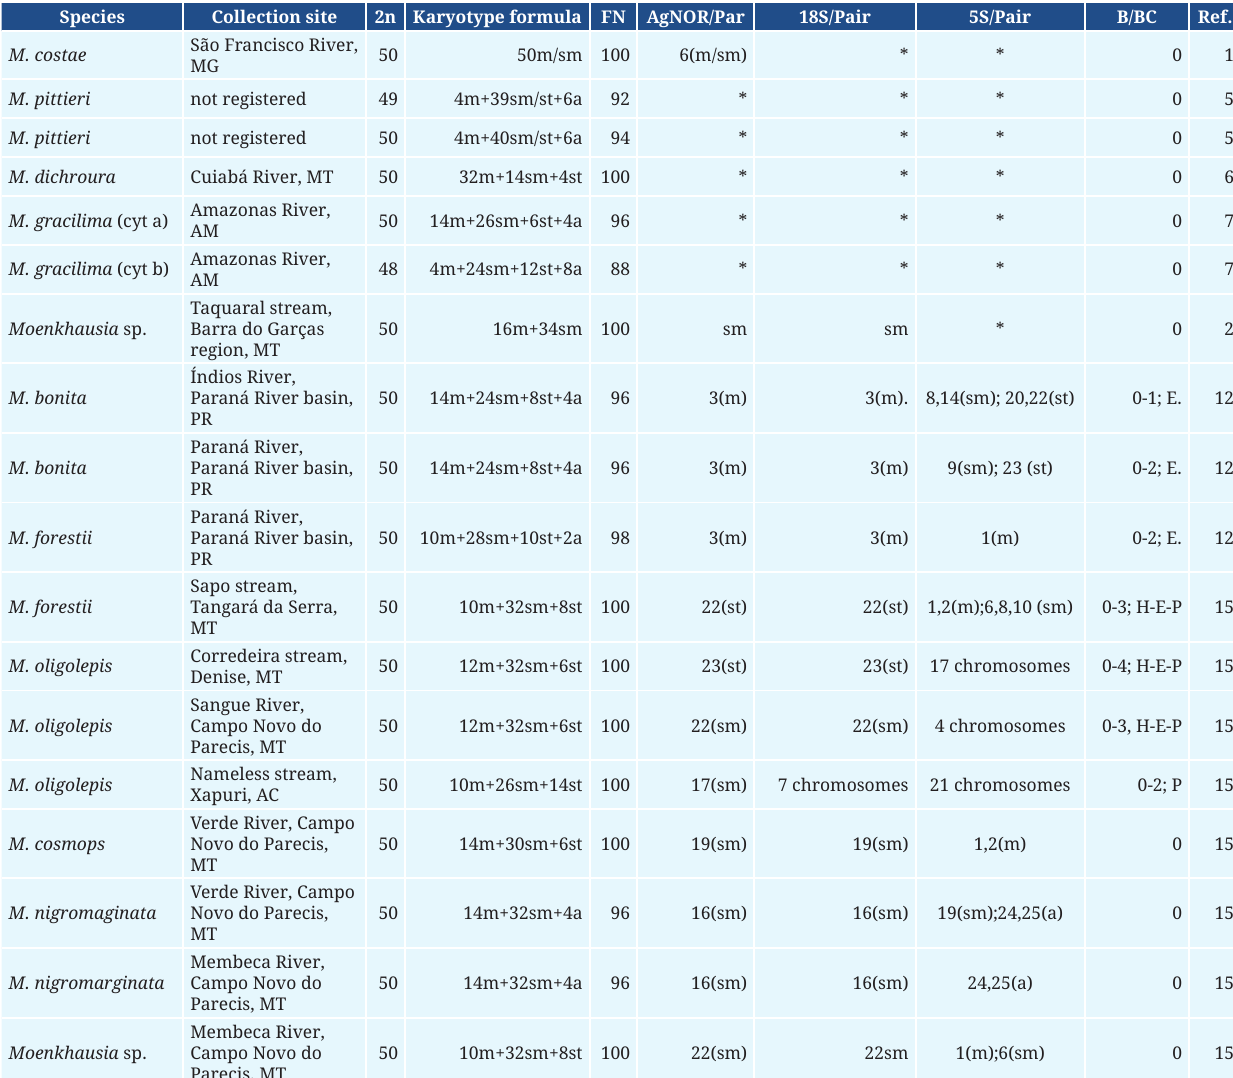
The occurrence of B chromosomes in the species of Moenkhausia was initially documented in specimens of M. intermedia (Portela et al ., 1988) and M. sanctaefilomenae (Foresti et al ., 1989). B microchromosomes were described in M. forestii while individuals of three populations of M. oligolepis presented three morphologically distinct types of B chromosomes (Nascimento et al ., 2020). The B chromosomes of M. sanctaefilomenae , characterized as microchromosomes due to their small size, are highly variable in number. They occur in cells with 1 to 8 of these elements, whose differences are found intra and inter-individually. These elements also vary in the amount of heterochromatin and can be euchromatic, partially euchromatic, or completely heterochromatic (Foresti et al ., 1989). For some populations of M. sanctaefilomenae, these extra chromosomes have some specific characteristics, such as restricted to males (Portela-Castro et al .,